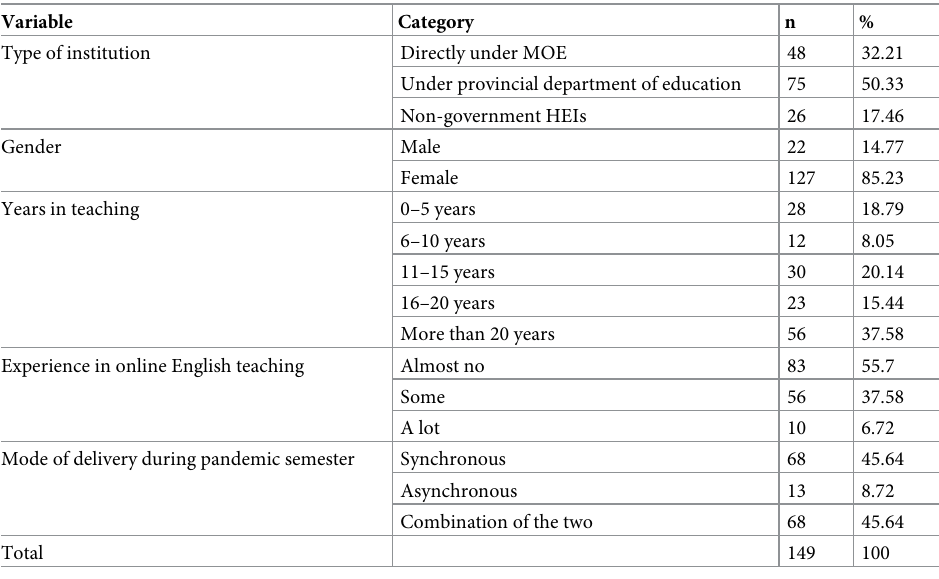
Table 2. Demographics for teacher